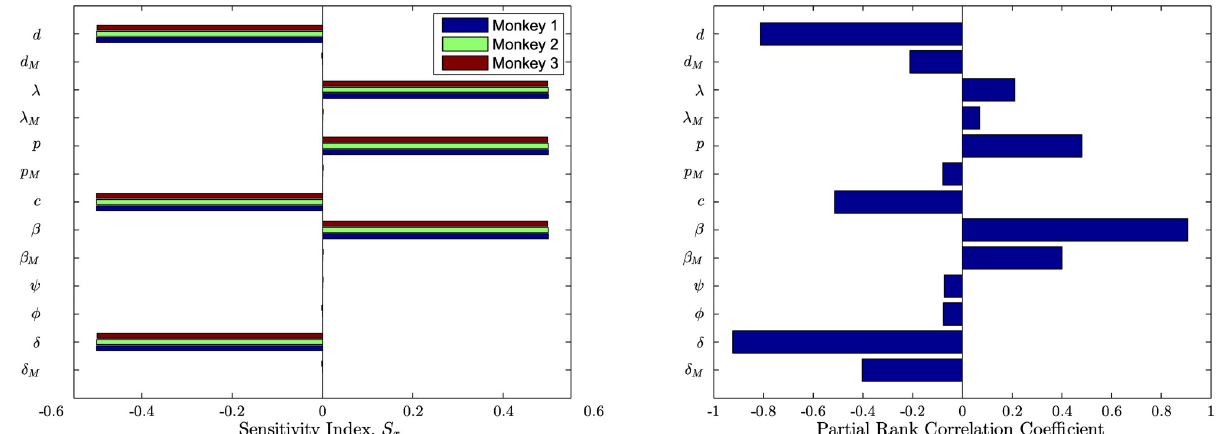
Fig 3. Sensitivity of parameter estimations to R . Local sensitivity of R based on sensitivity index (left) and the partial rank correlation coefficients 0 0 for global sensitivity of R based on Latin Hypercube sampling 0